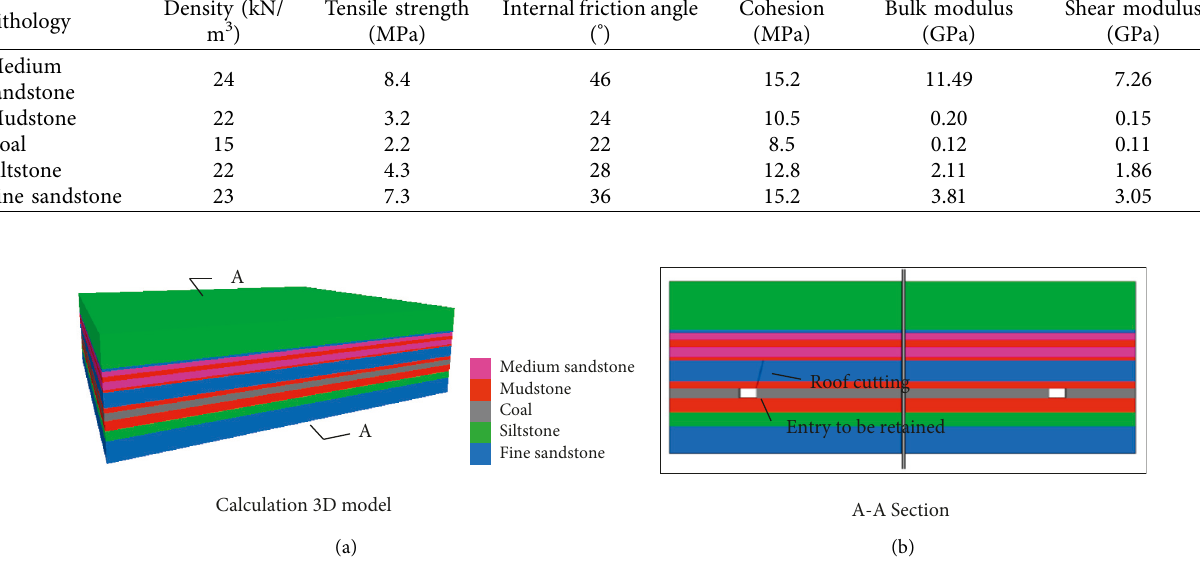
Figure 7: Numerical calculation model. (a) Calculation 3D model. (b) A-A